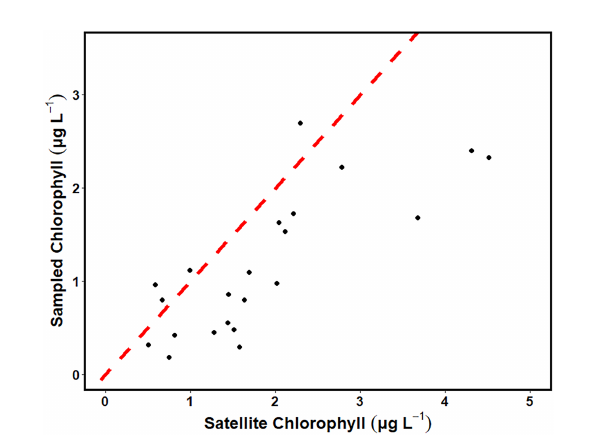
FIGURE 12 Correlation between the mean of sampled surface chlorophyll